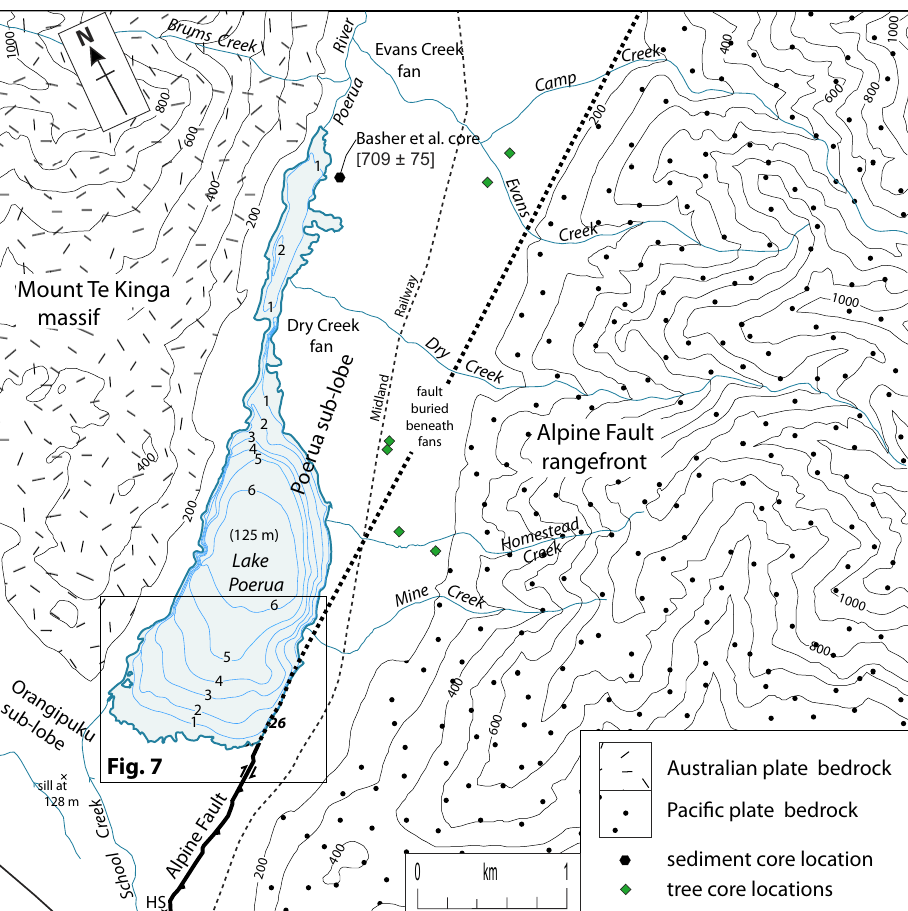
Fig. 4. Map of the Inchbonnie-Poerua area, highlighting the bathymetry of Lake Poerua (in m). Contour interval for the valley is 100m. Subaerial traces of the Alpine Fault and the Inchbonnie trench site (HS) are indicated at bottom left. All located tree stumps occur within box marked Fig. 7. A core from near the northern tip of the lake has a single radiocarbon date. Trees cored for dendrochronologic ages are indicated by diamonds.